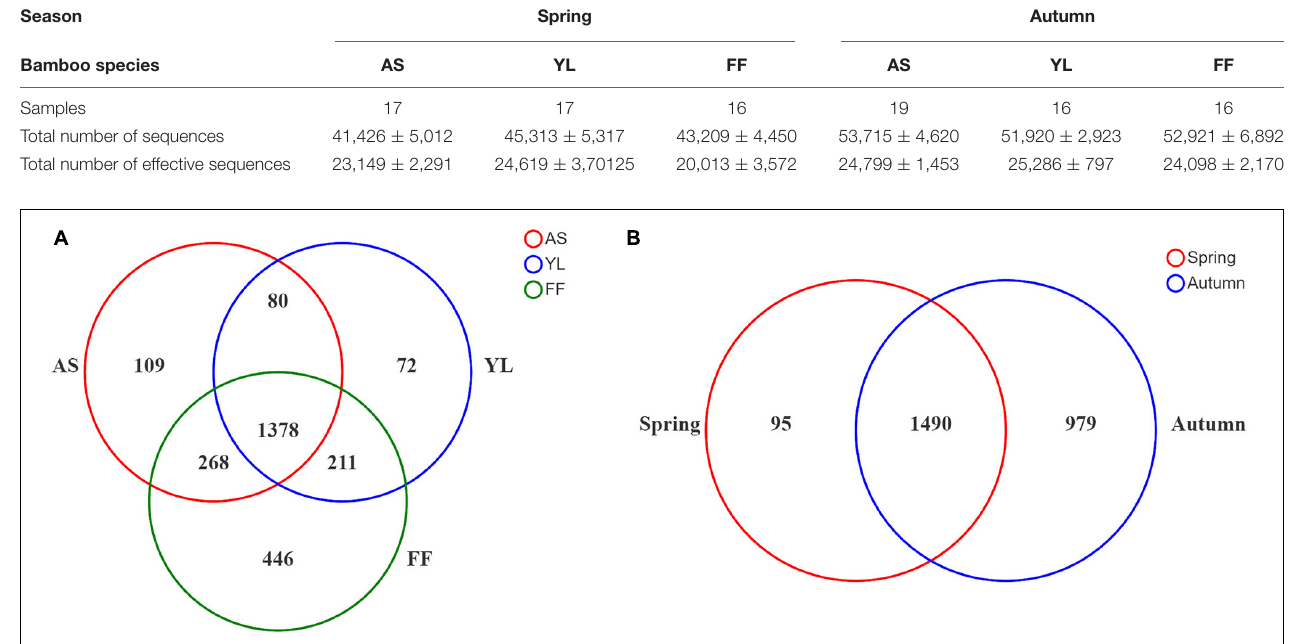
TABLE 1 | Statistics table of each sample and sequence (AS, A. spanostachya ; YL, Y. lineolate ; and FF, F. ferax ) (Mean ± SD ).